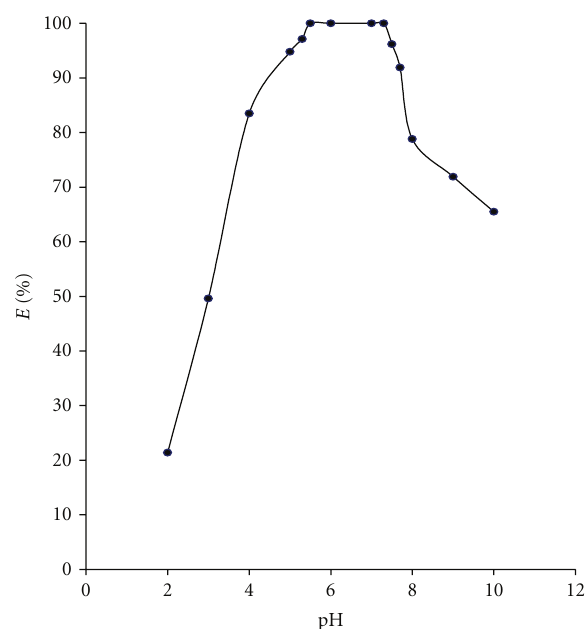
Figure 1: Extraction behaviour of neodymium(III) as a function of pH at 0.06 M sodium succinate; 0.1 M N- n -octylaniline in xylene.